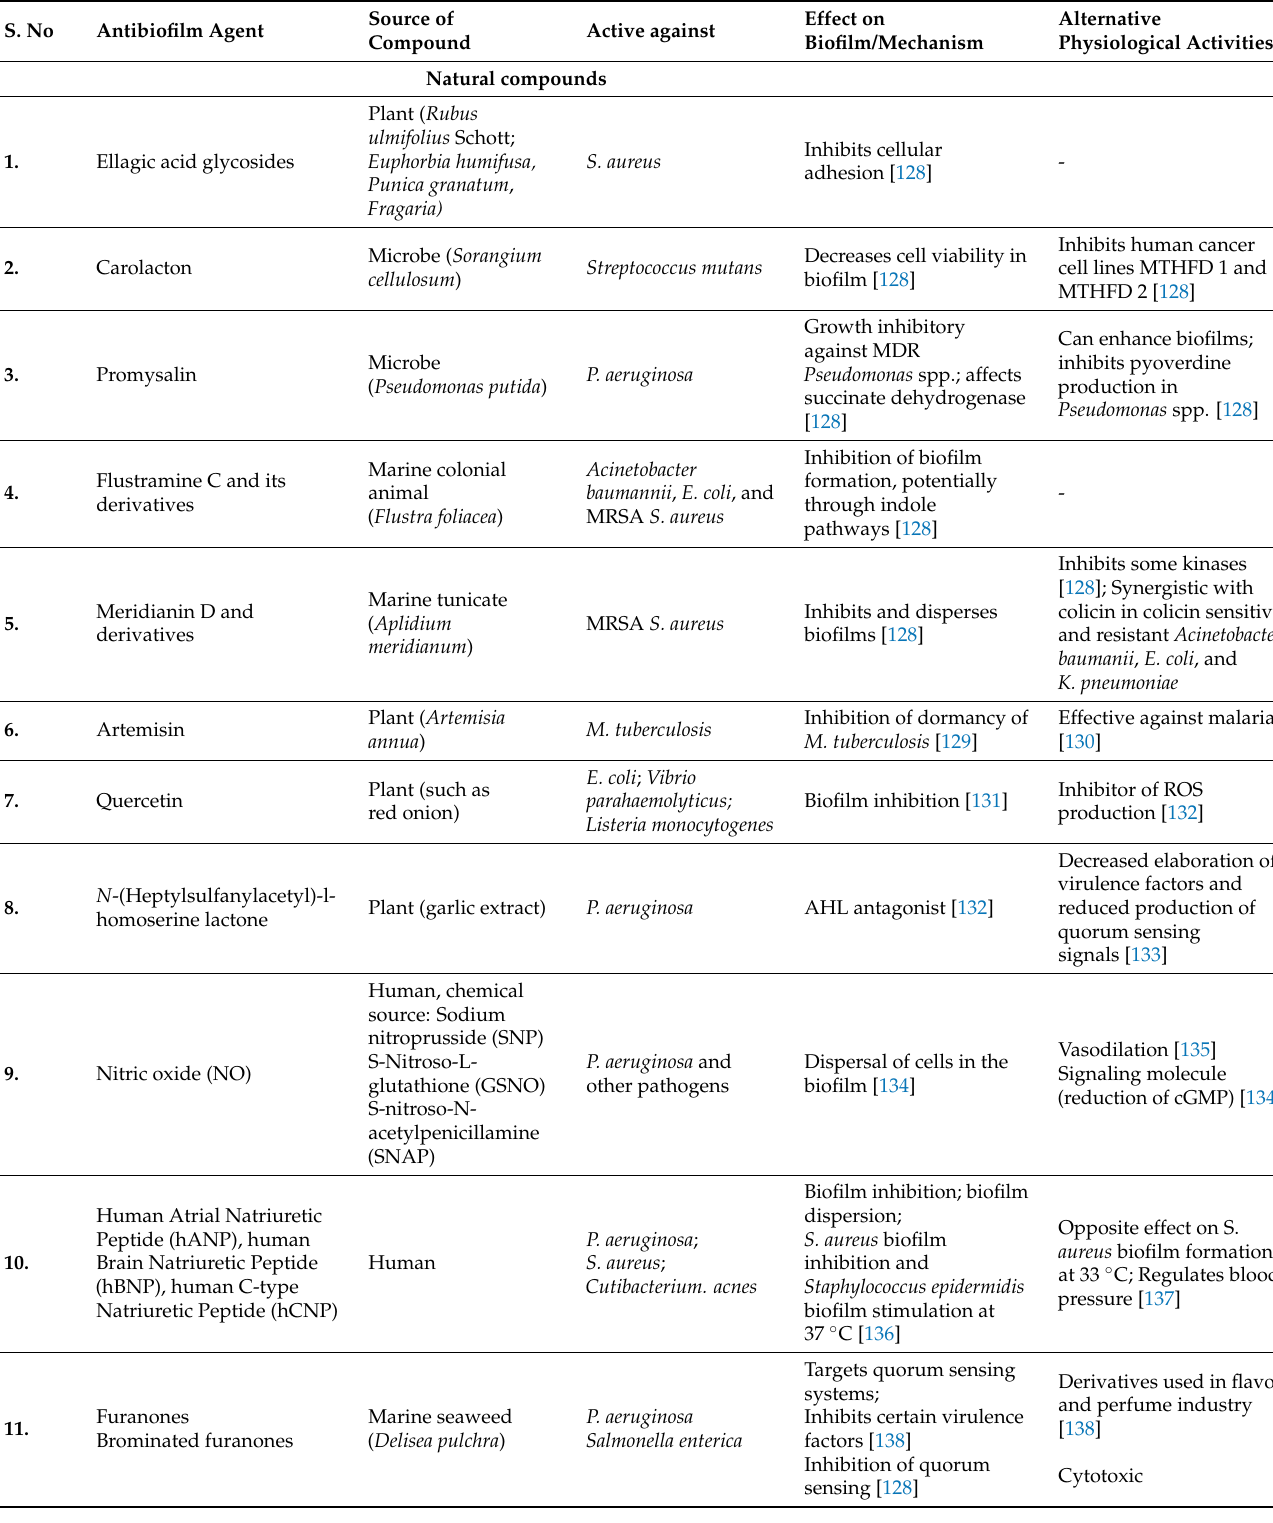
Table 2. Selected identified anti-biofilm agents and their major physiological effects on the targeted microbes and the